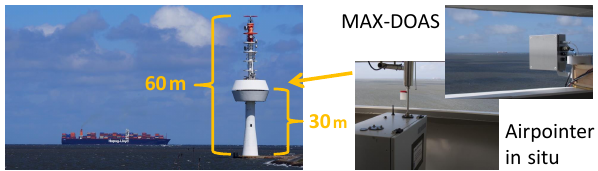
Figure 2. Radar tower Neuwerk with MAX-DOAS and the in situ measurement